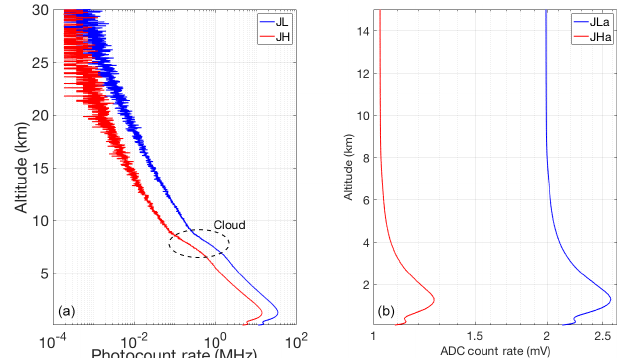
Figure 12. Count rate for 30min of coadded RALMO measure- ments from 23:00UT on 5 July 2011; (a) Photon-counting channels (blue curve, JL; red curve, JH); (b) Analog